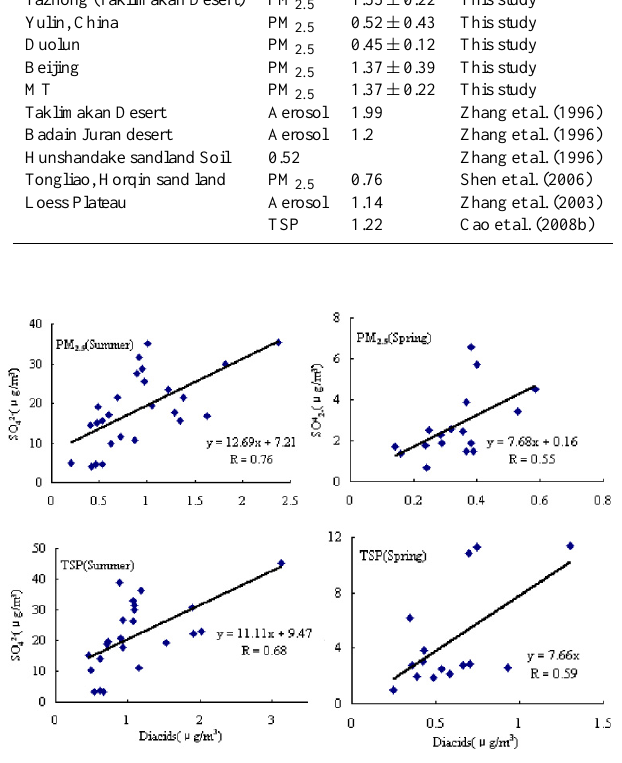
Fig. 10. Scatter plots of SO 2 − CH 4 C 2 O 2 − , and C 2 O 2 − 4